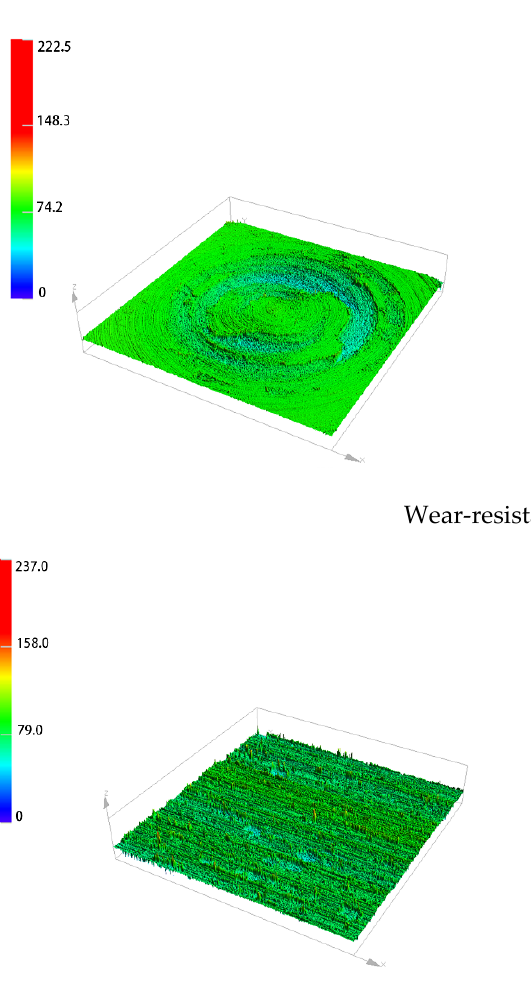
Figure 10. Surface morphology of different metal grinding heads before and after the friction with NR/BR composites (the width of one image is 1272um).